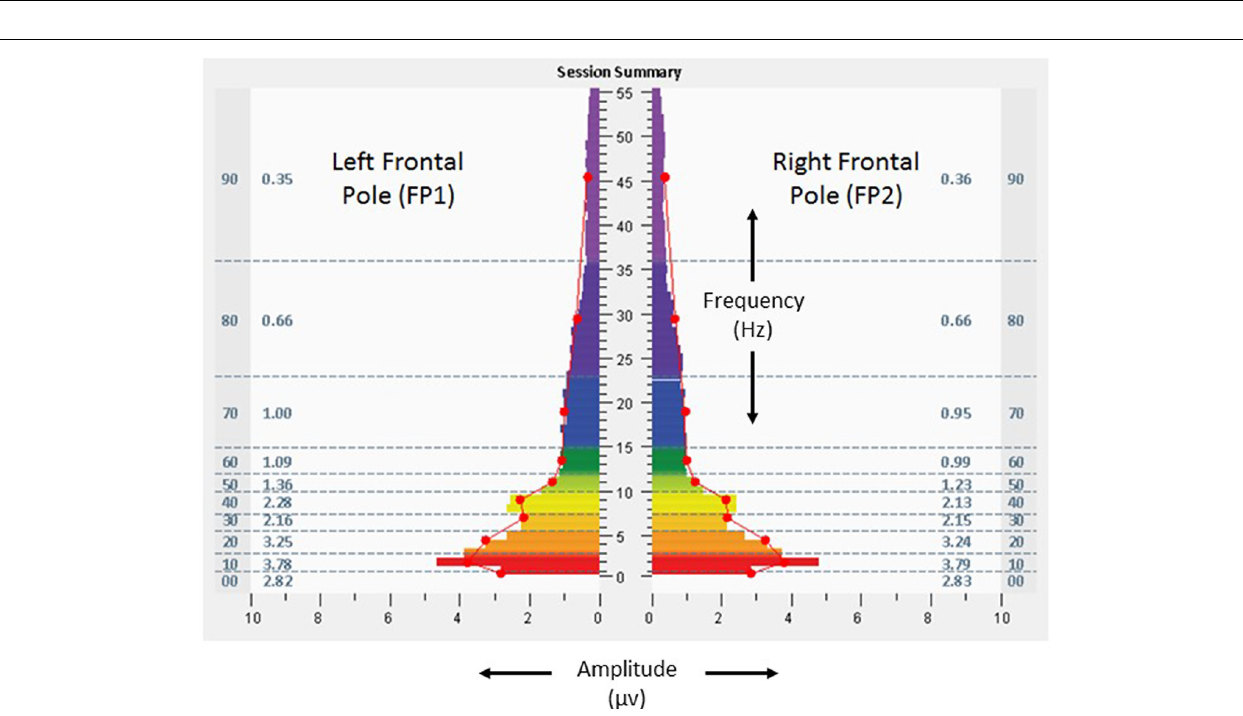
FIGURE 4 | Fast Fourier Transform spectral display of brain electrical activity observed during the penultimate minute of the penultimate allostatic technology session at the left and right frontal poles (FP1 left, FP2 right), with eyes open, from the 18 years-old learner described in the text. See Figure 2 legend for detailed explanation of data